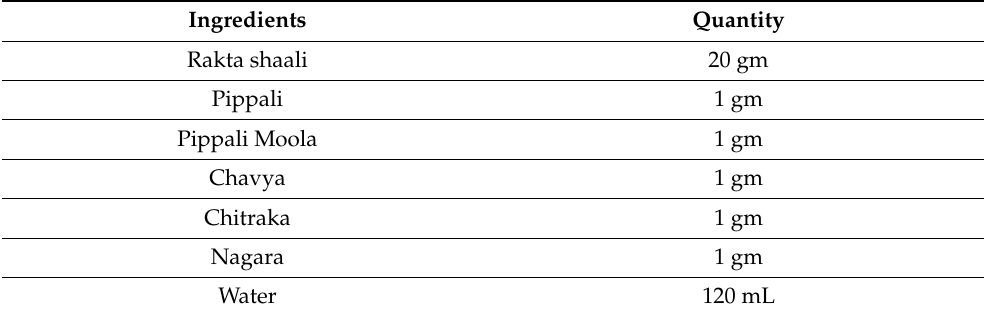
Table 1. Gruel Preparation: Panchakola Siddha Yavagu was prepared by adding 1 part of rice (20 gm) with 6 parts (120 mL) of water. After the gruel was prepared 5 g of Panchakola churna was added to it. Ingredients and their quantities are given below. Ingredients Quantity Rakta shaali 20 gm 1